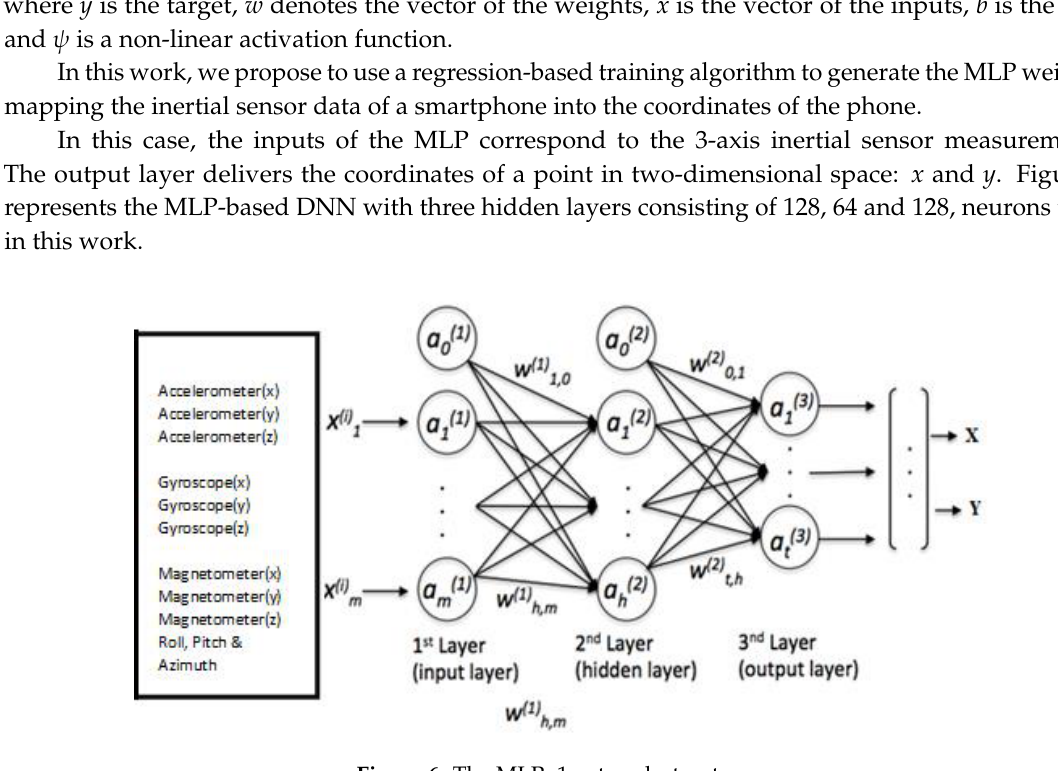
Figure 5. Heatmap of the magnitude of the magnetic field in each place in the building.